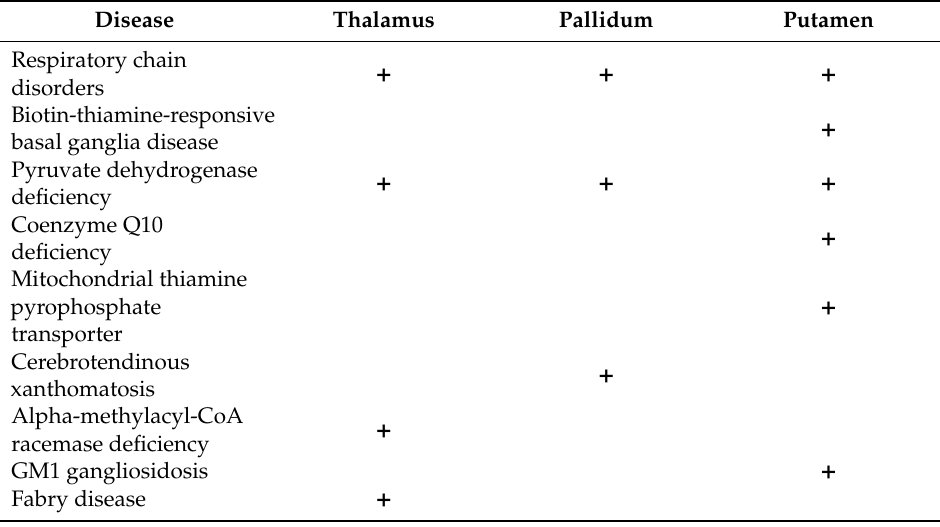
Table 2. Basal ganglia neuroimaging abnormalities in neurometabolic diseases